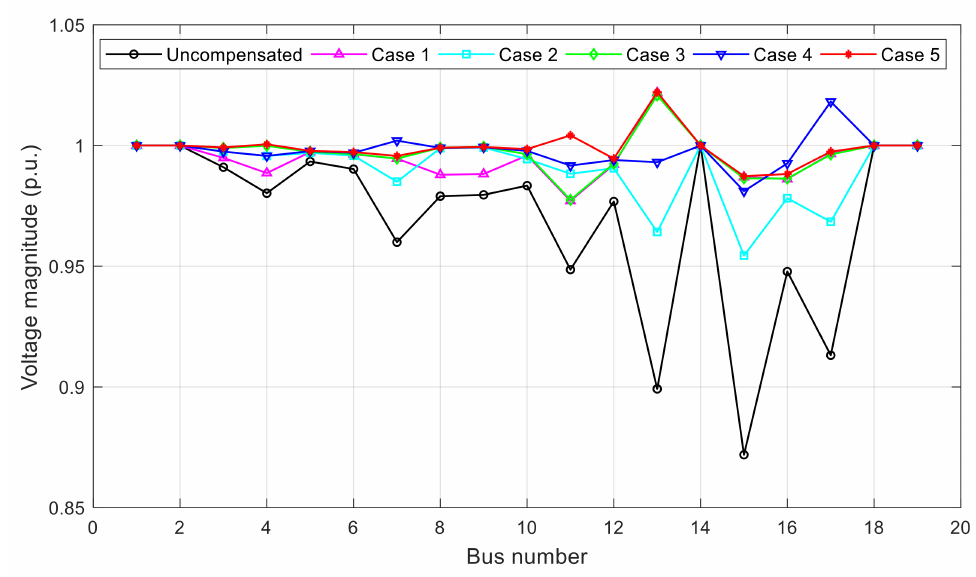
Figure 11. Voltage profiles of various cases of the IUPS.